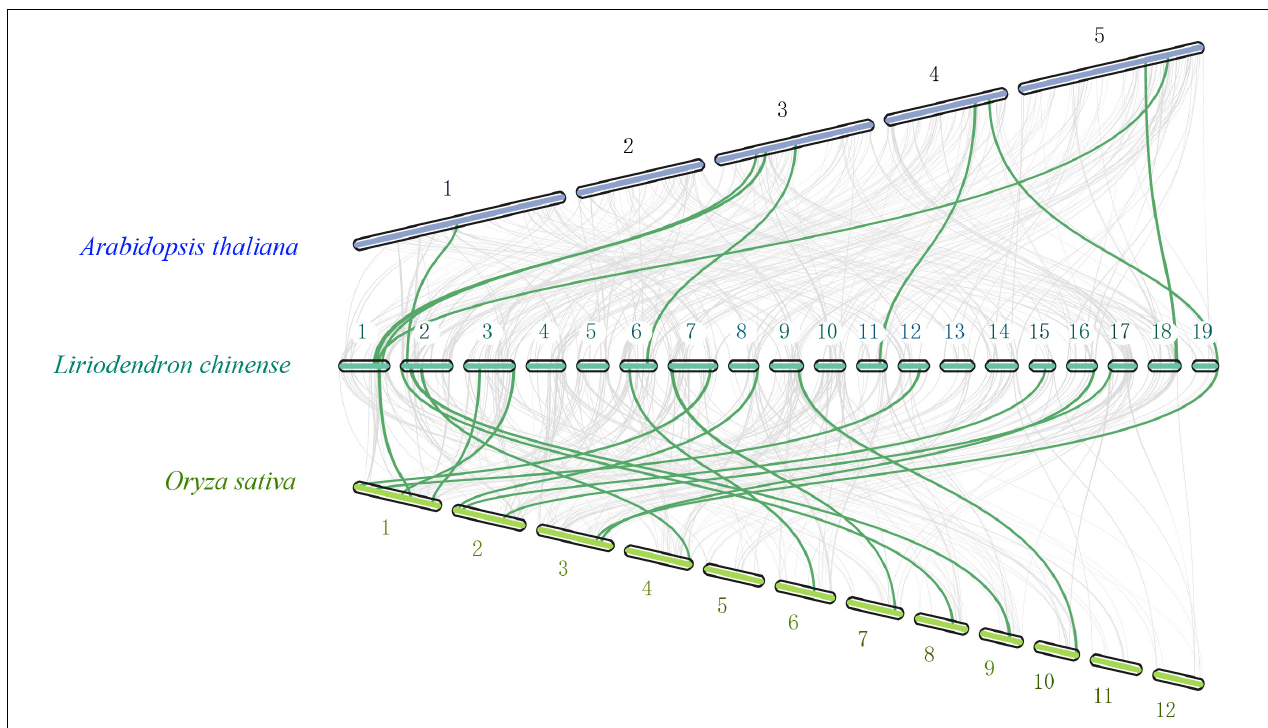
FIGURE 3 | Collinearity analyses of MYB genes among Lchi , Oryza sativa , and Arabidopsi s. The genomic linear blocks of Lchi , Oryza sativa , and Arabidopsis are represented by gray lines, while the syntenic MYB gene pairs are highlighted by the green lines. The number on the chromosome represents the chromosome ordinal number (Wang et al.,